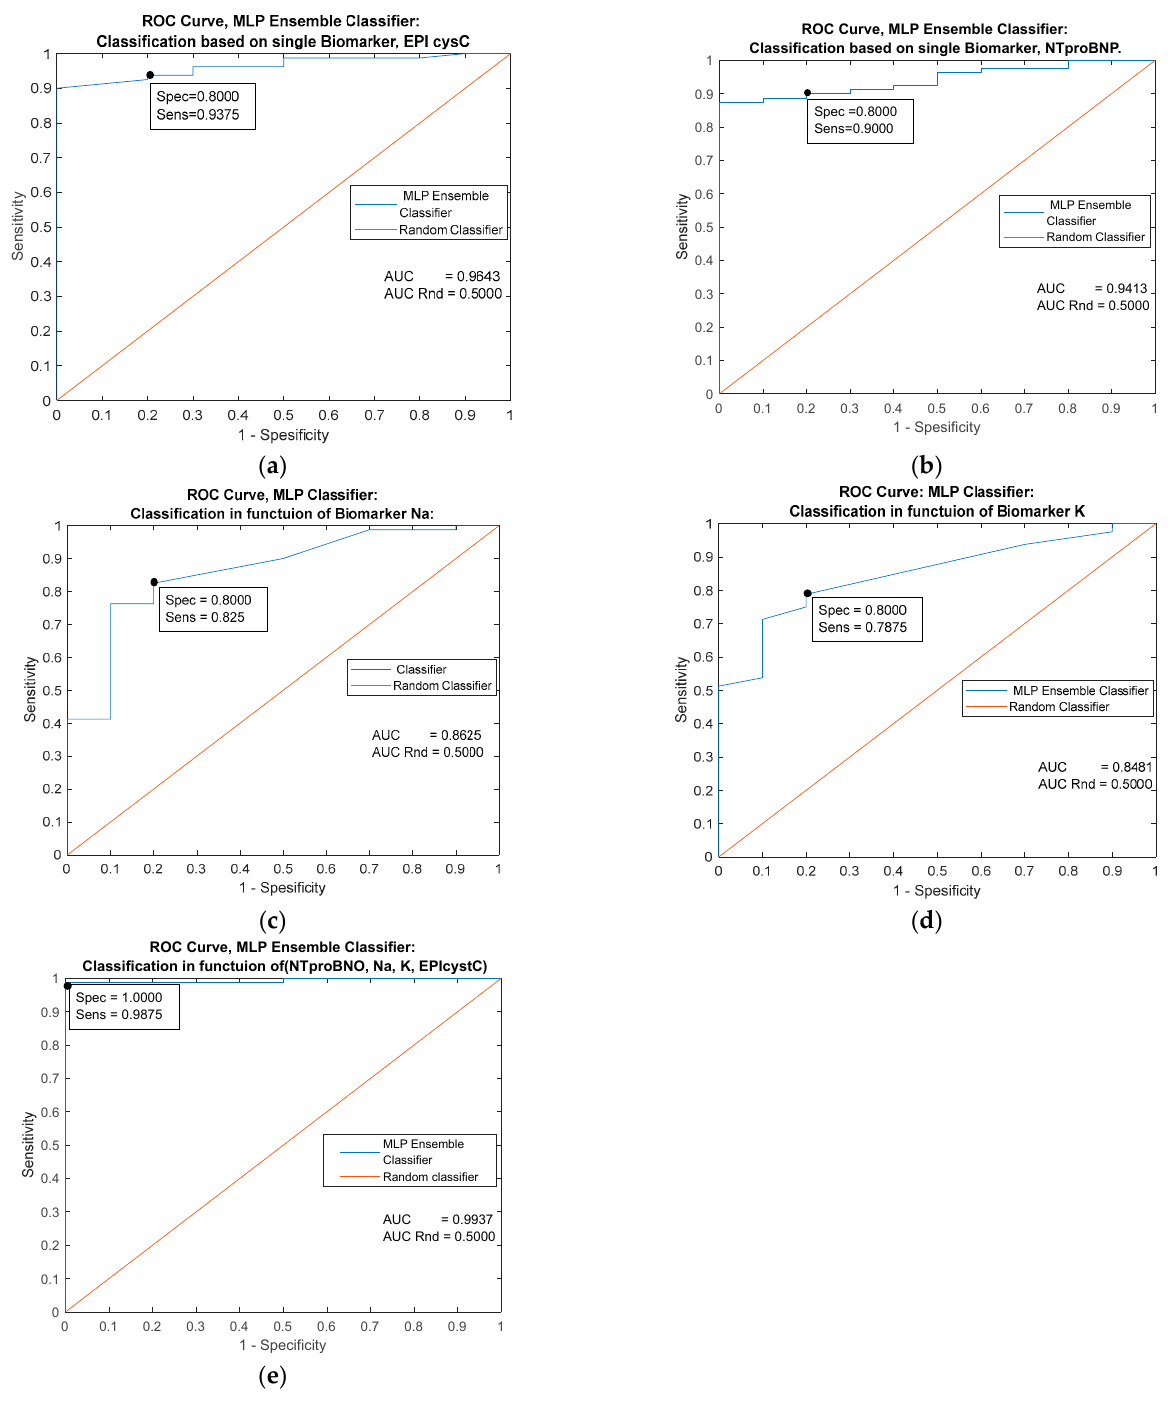
Figure 3. Performance comparison of MLP classifiers based on four individual predictors ( a – d ) and on the combination of all the mentioned predictors ( e ).